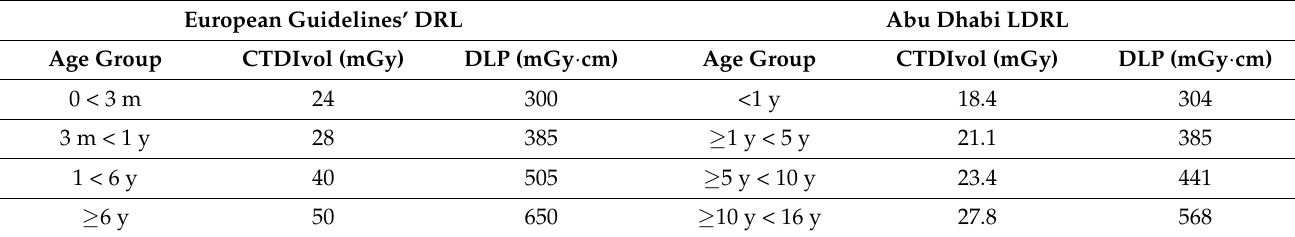
Table 3. Pediatric head CT local DRLs in Abu Dhabi in comparison with European DRLs; “y” represents year, and “m” represents months.